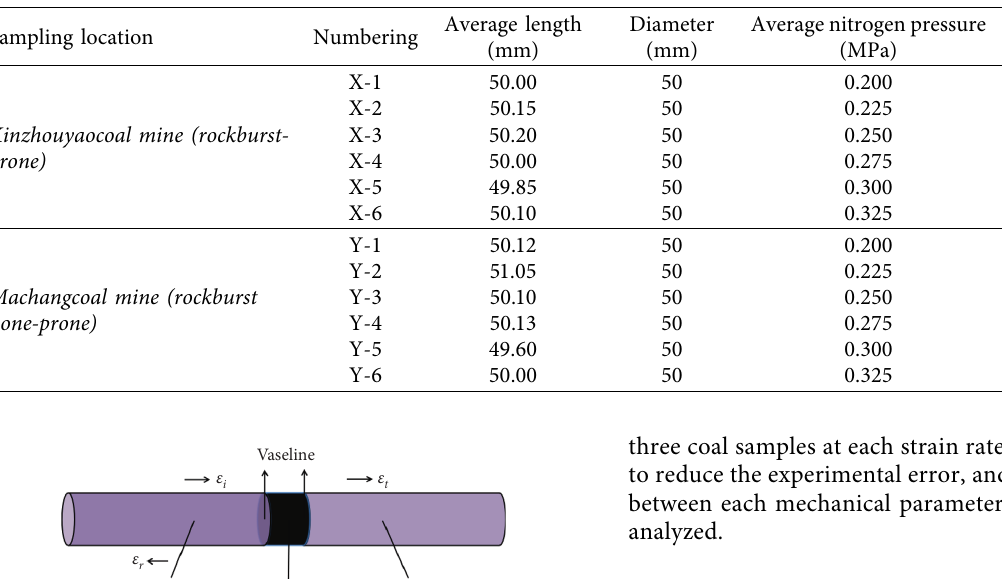
Table 2: Variation of strain rate under different pressures.